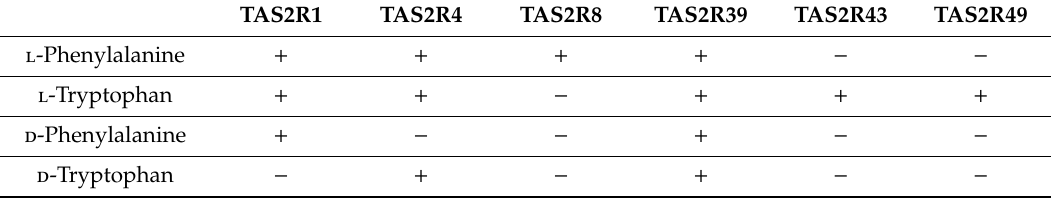
Table 2. Response profile of six TAS2Rs to d - and l -forms of tryptophan [15,24] and phenylalanine [15]. TAS2R1 TAS2R4 TAS2R8 TAS2R39 TAS2R43